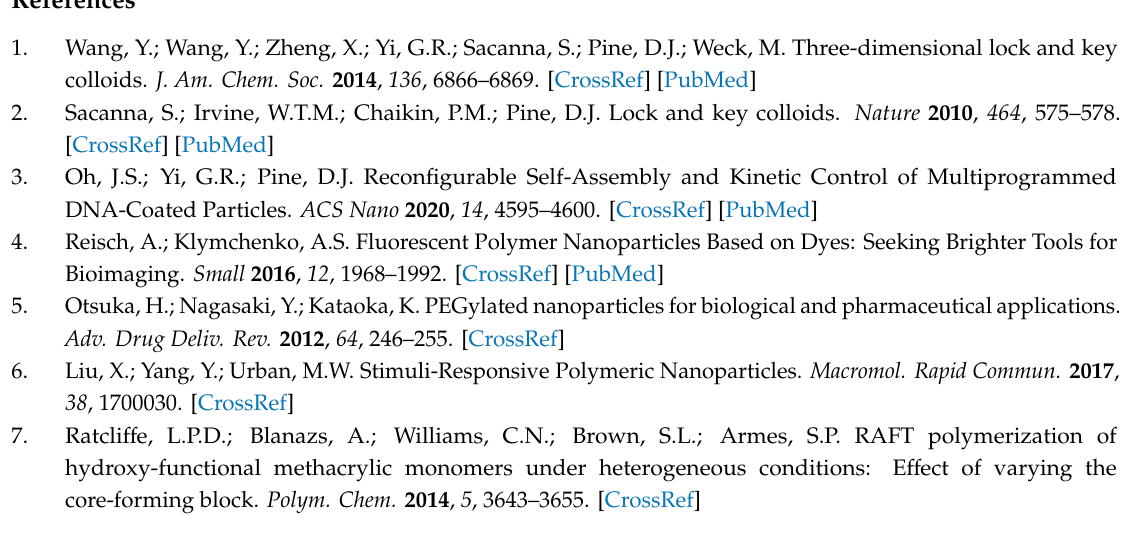
Figure S1: Photograph of particles after centrifugation at 10,000 rpm for 5 min for (left) pristine PS34k-b-PB25k particles and (right) MPA-modified particles. While pristine PS 34k - b -PB 25k particles floated on the top of the aqueous phase, MPA-modified particles were settled to the bottom. Figure S2: Magnified FT-IR spectra of PS 34k - b -PB 25k particles modified with MPA for a varying degree of r = 0, 0.1, 0.2, 0.5. Normalization to C–H signal from PS block on 2800–3000 cm − 1 shows a gradual increase in signal intensity near 1722 cm − 1 corresponding to the carbonyl (C = O, purple) stretch from the carboxyl acid group. Table S1: Calculated conversion of PB modification for varying r. Figure S3: Full spectra of 1H NMR for MPA-modified PS 34k - b -PB 25k particles with r = 0, 0.1, 0.2, and 0.5. Figure S4: TEM images of (a) before and (b) after MPA modification of onion-like PS 34k - b -PB 25k particles. Figure S5: TEM image of MPA-modified PS 34k - b -PB 25k particles treated with (a) OsO4 and (b) Au precursor (HAuCl4 · 3H2O) before TEM imaging. Figure S6: SEM images of PS 34k - b -PB 25k particles after reacting with MPA under UV irradiation for (a) 1 h, (b) 2 h, (c) 3 h. Figure S7: SEM image of (a) pristine PS 34k - b -PB 25k particle and (b) PETMP-modified particle (r = 0.5). (c) FT-IR spectra comparing the pristine PS 34k - b -PB 25k particle (black) and PETMP-modified particle (blue). (d) Schematic showing the crosslinking of PB domains via PETMP having branched tetrathiol groups. Figure S8: SEM images of PS 34k - b -PB 25k particles produced by membrane emulsification using di ff erent d pore , where (a) 0.5, (b) 1.1, and (c) 2.1 µ m of pore size was used